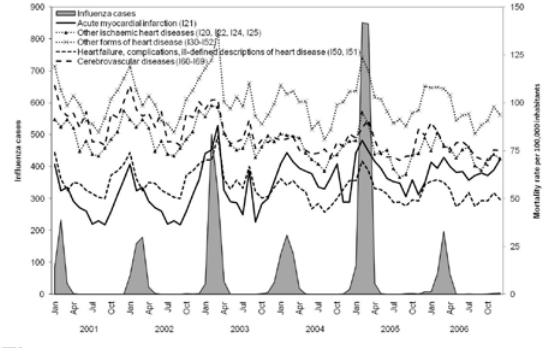
Figure 5. IInfluenza cases and mortality from diseases of the circulatory system in Baden-Wuerttemberg, Germany, 2001-2006.